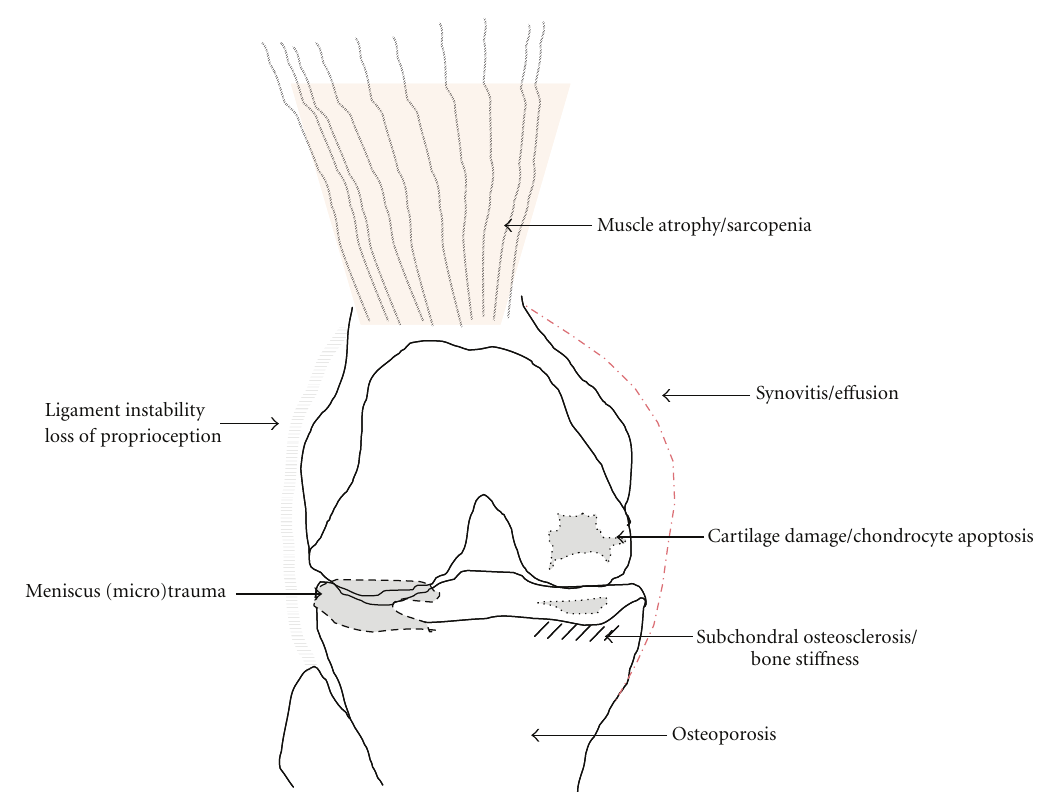
Figure 1: Osteoarthritis as a whole joint disease in the